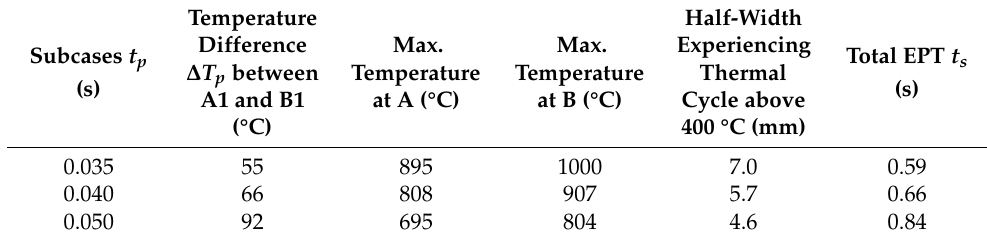
Table 1. Detailed results of Joule heating.